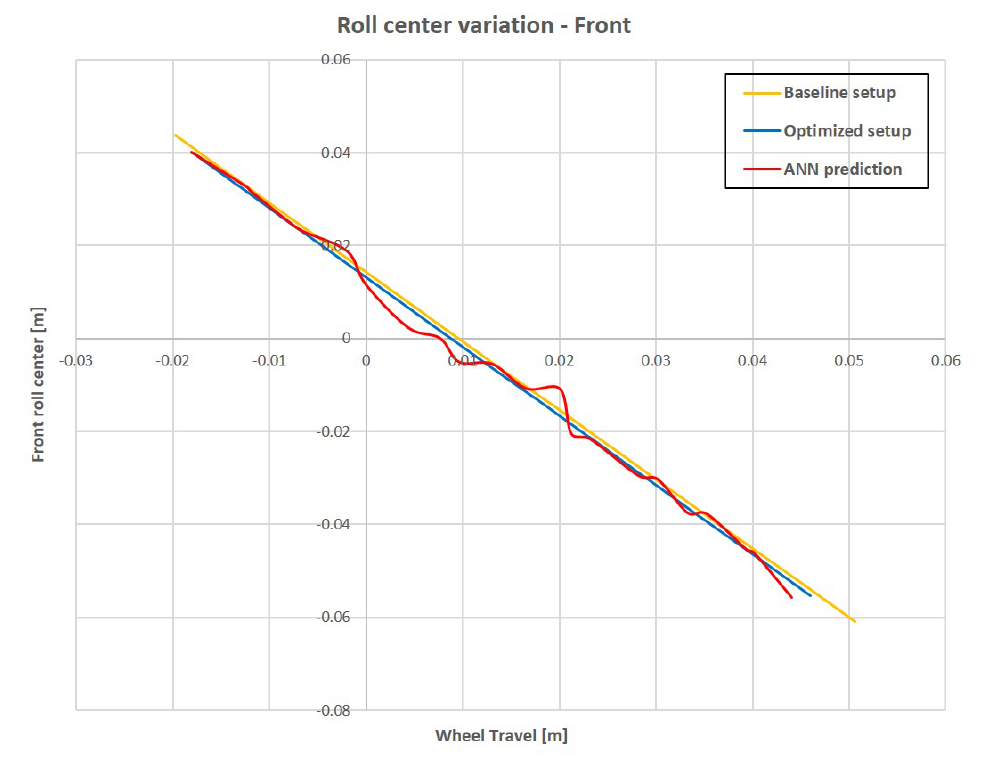
Figure 29. Front roll center variation